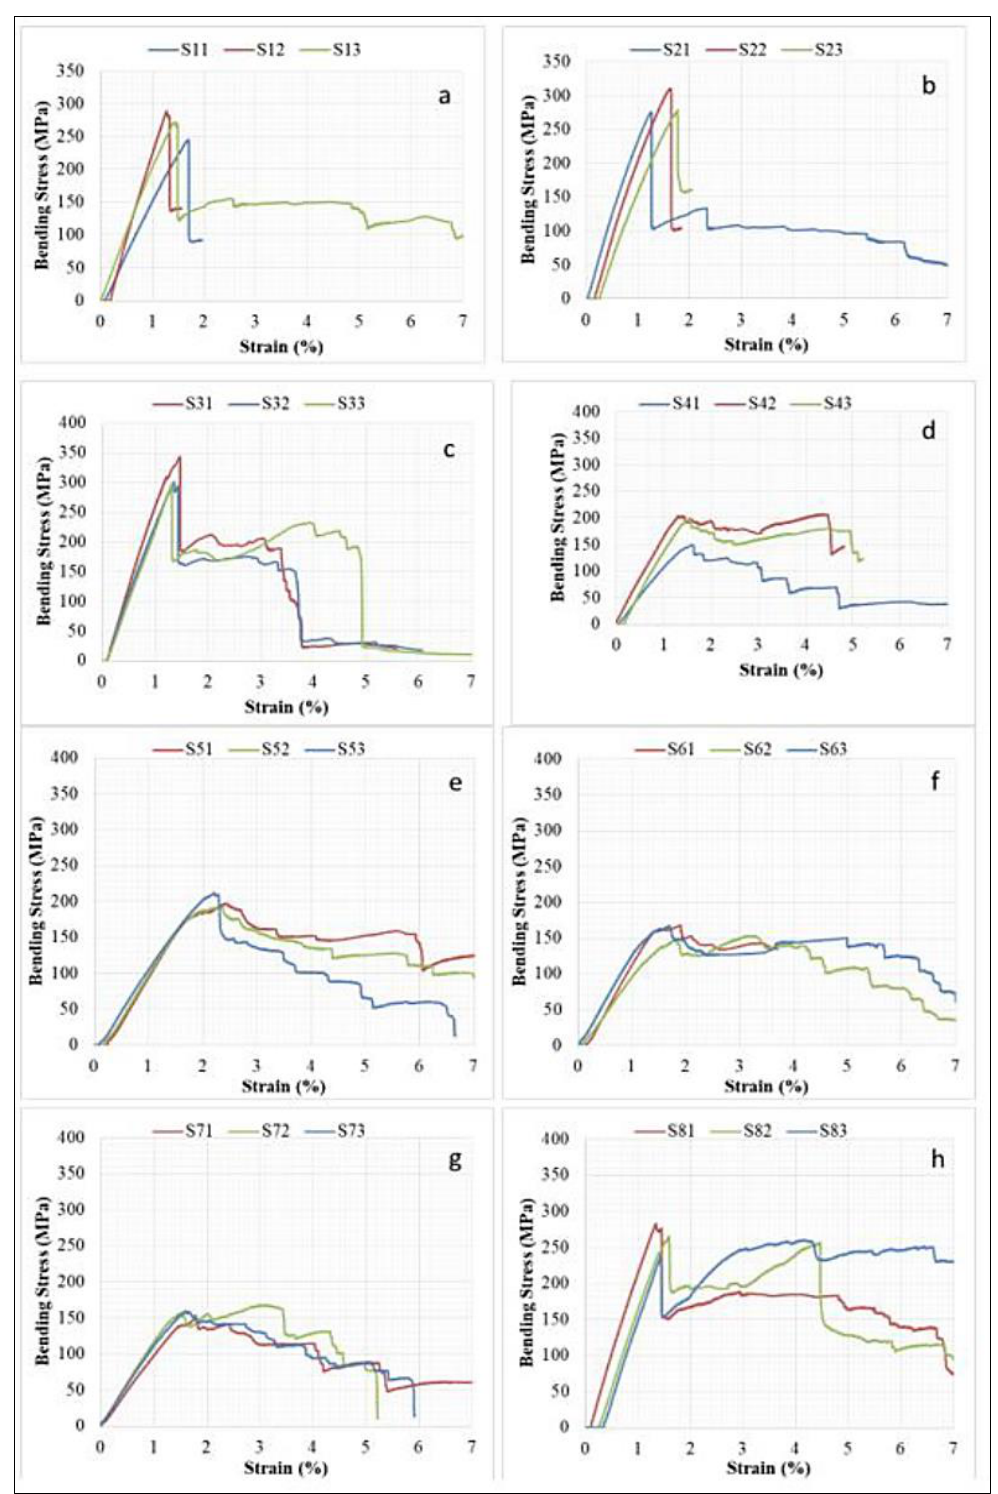
Figure 8: Bending stress strain curves for hybrid composite panels: (a) S1, (b) S2, (c) S3, (d) S4, (e) S5, (f) S6, (g) S7, and (h)